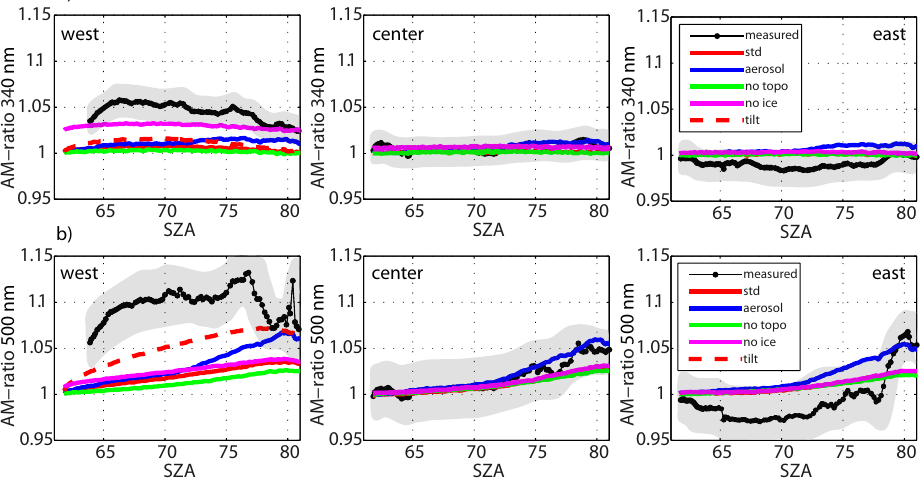
Figure 9. Ratios of afternoon/morning global irradiances (AM ratios) at stations west, center and east for wavelengths 340nm (a) and 500nm (b) . Measured ratios (dots) are compared to the relevant model scenarios (colored curves). The legends apply to all panels. The measurement uncertainties are illustrated with gray shaded areas. The tilt scenario only applies to station